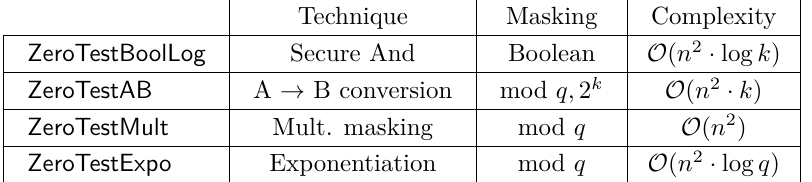
Table 2: Complexities of zero testing a single value with n arithmetic shares, and a modulus 2 k or a k -bit prime q